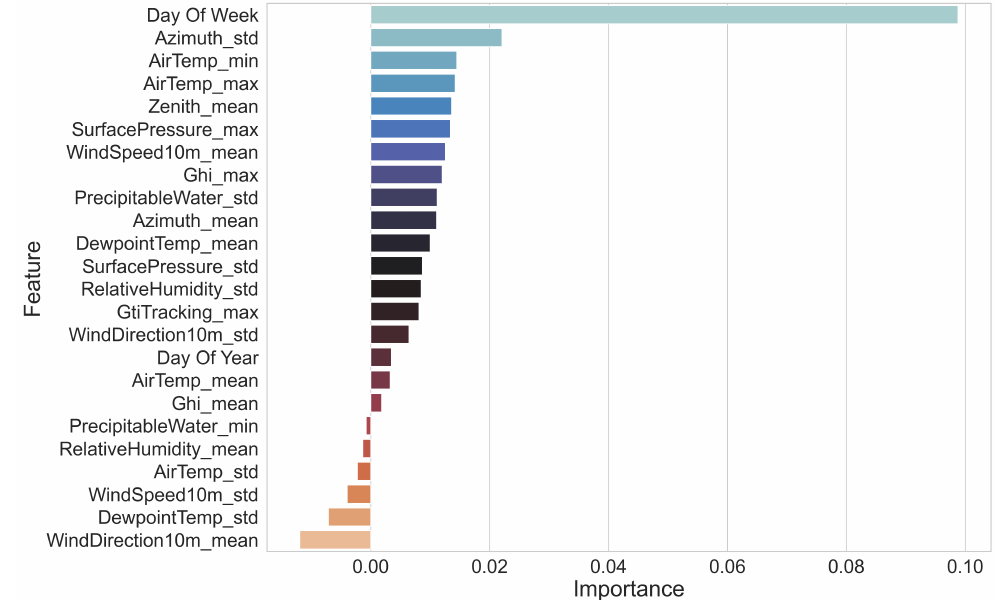
Figure 13. The permutation importance of each of the features chosen as part of our fitted Random Forest